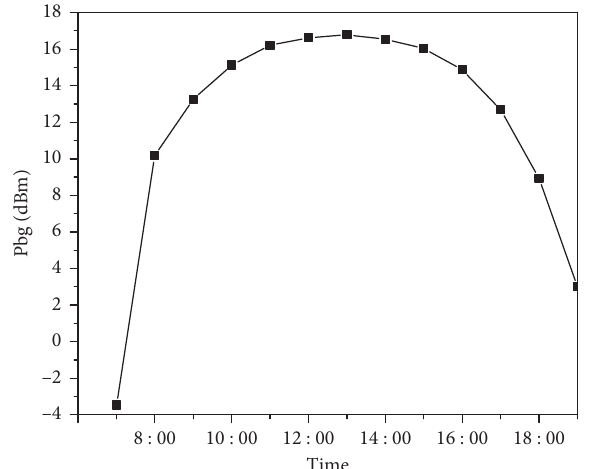
Figure 1: Variation of background light noise during daytime.